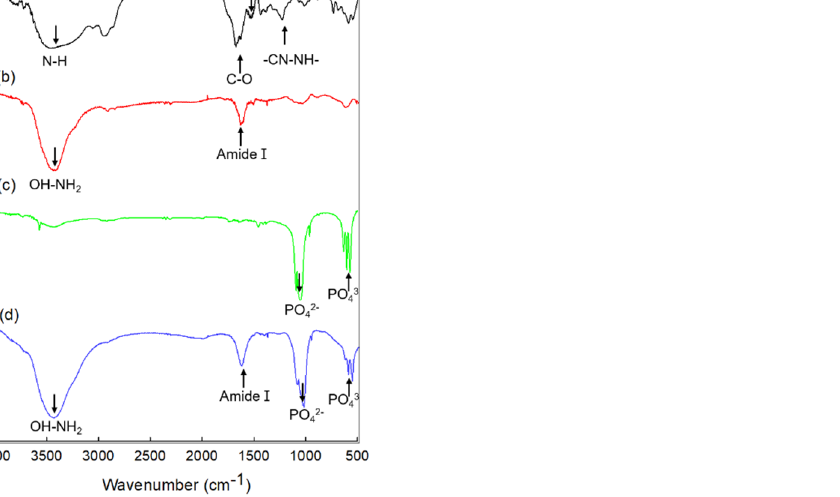
Figure 3. FTIR spectra of ( a ) FC, ( b ) pure BGM, ( c ) FC/GG membrane, and ( d ) FC/GG − BGM mem- brane.